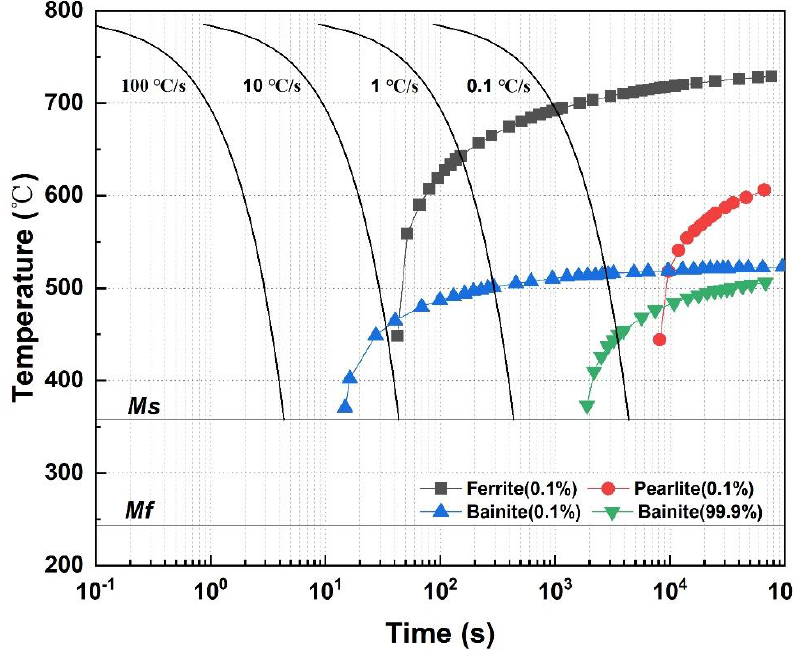
Figure 1. The continuous cooling transition (CCT) curves of 25CrNi2MoVE steel.